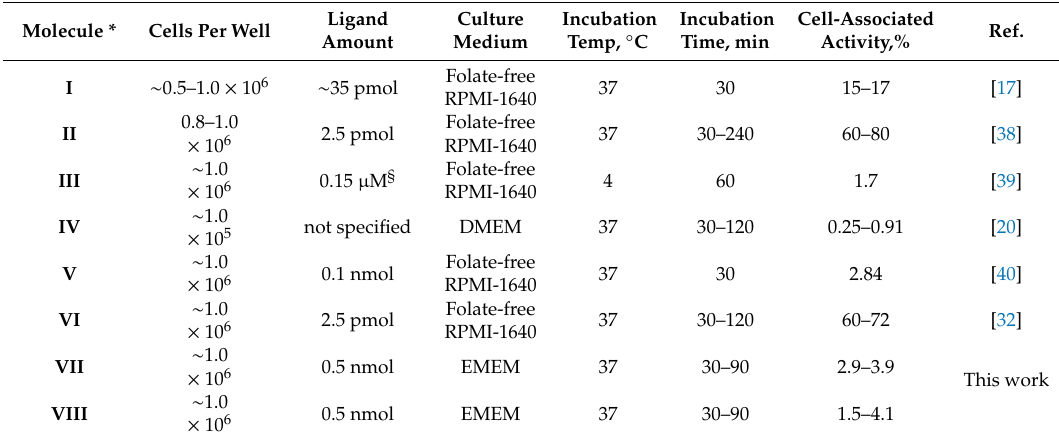
Table 5. Results of in vitro binding assays with KB cells for folate-based conjugates. Molecule * Cells Per Well